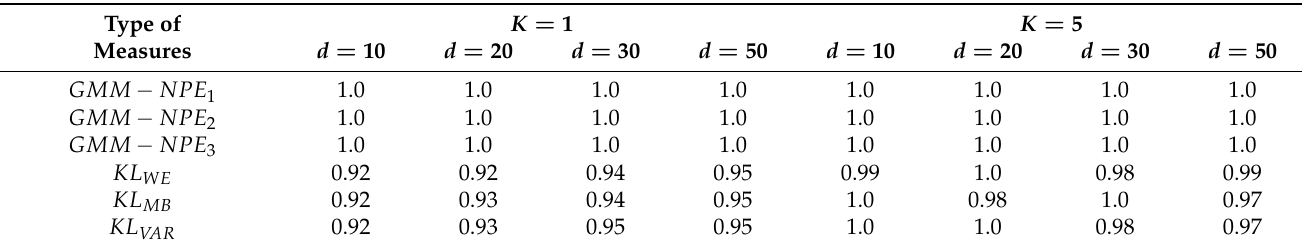
Table 2. Results in the form of recognition accuracy, obtained on the synthetic data: l = 1, t ∈ [ 0,5 ] , N = 800, M = 200, m 1 , m 2 =